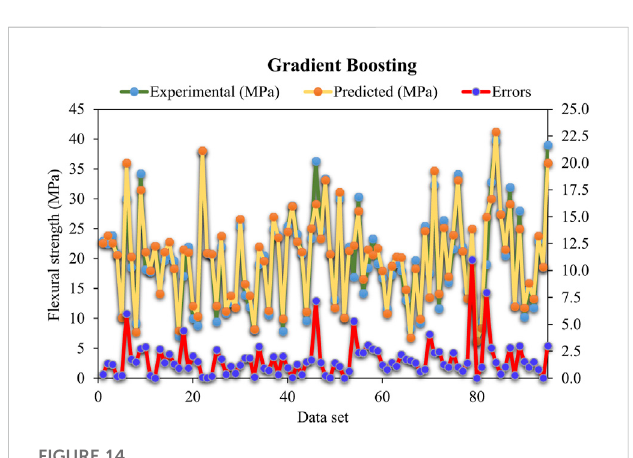
FIGURE 14 Difference of errors among actual and predicted UHPC FS — GB